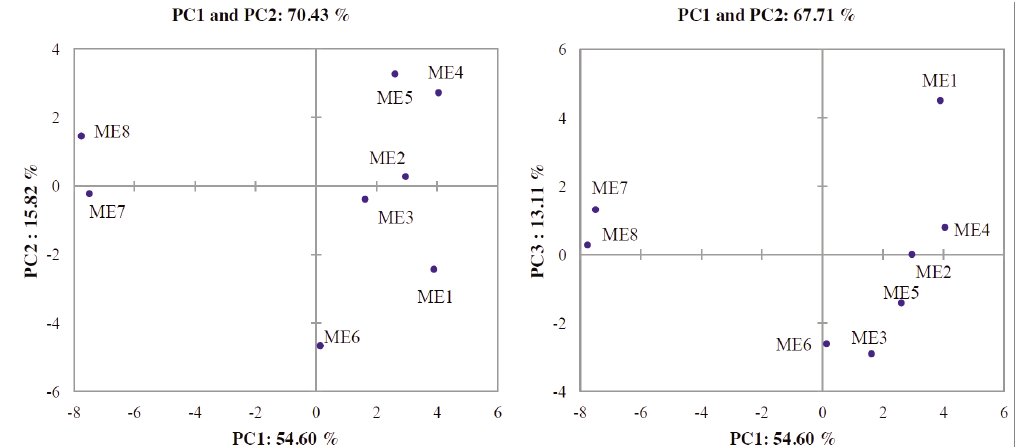
Fig. 2 ­ Loading plots of the first, second and third Principal Component showing the position of